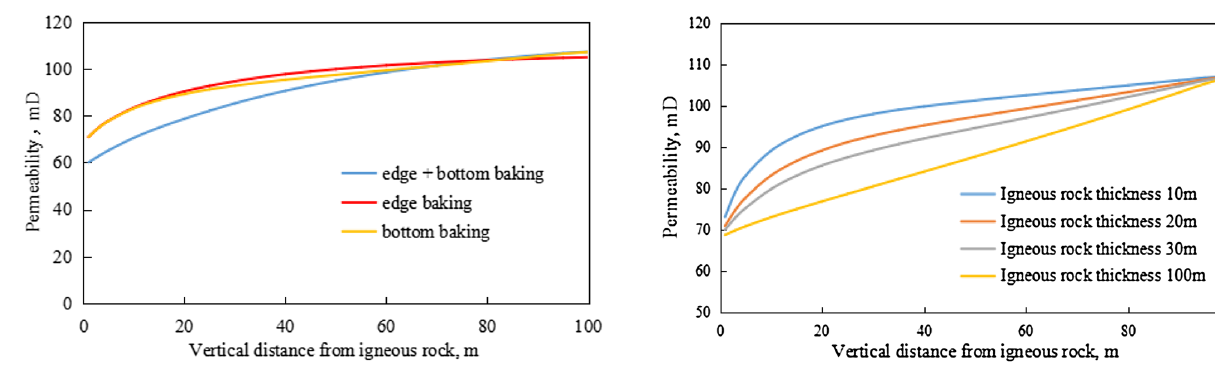
Fig. 8 Effect of different baking types on permeability Fig. 9 Effect of different igneous rock thickness on permeability